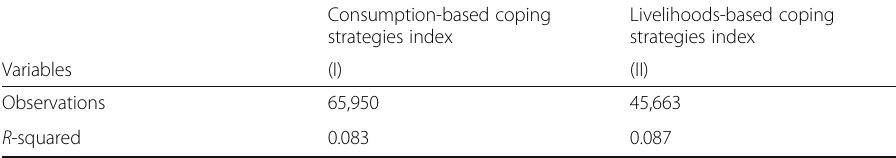
Table 6 OLS estimates of the impact gender on coping strategies (Continued) Consumption-based coping strategies index